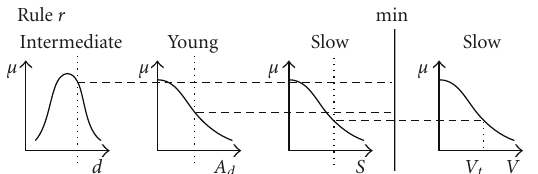
Figure 2: The reasoning procedure for Tsukamoto defuzzification